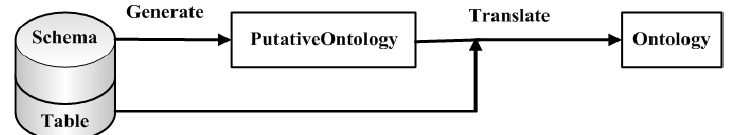
Figure 6. A putative ontology is generated from relational database tables.